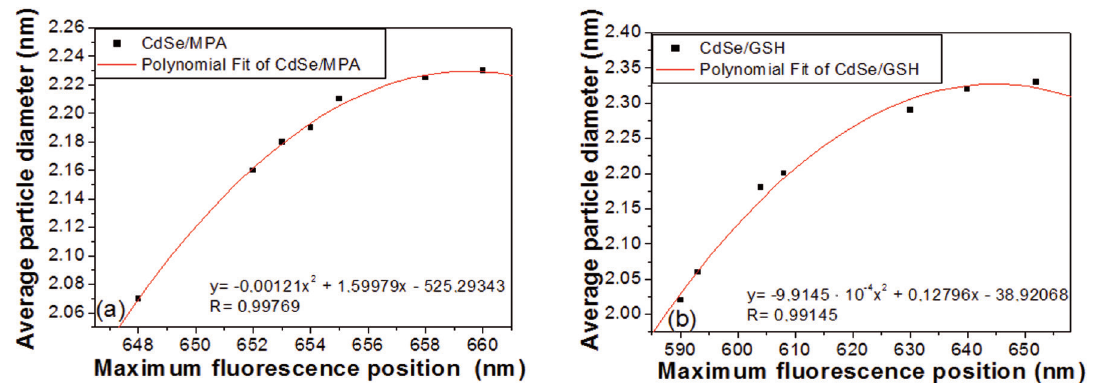
Figure 9: Calibration curves for the position of maximum fluorescence versus the diameter calculated for QDs: (a) MPA-capped CdSe QDs and (b) GSH-capped CdSe QDs.